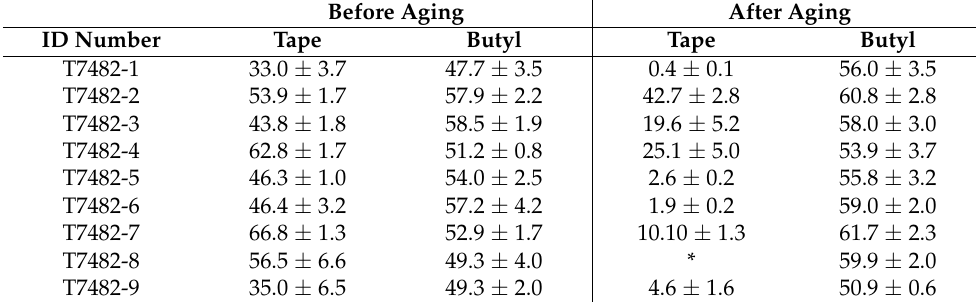
Table 8. Adhesive strength [N/50